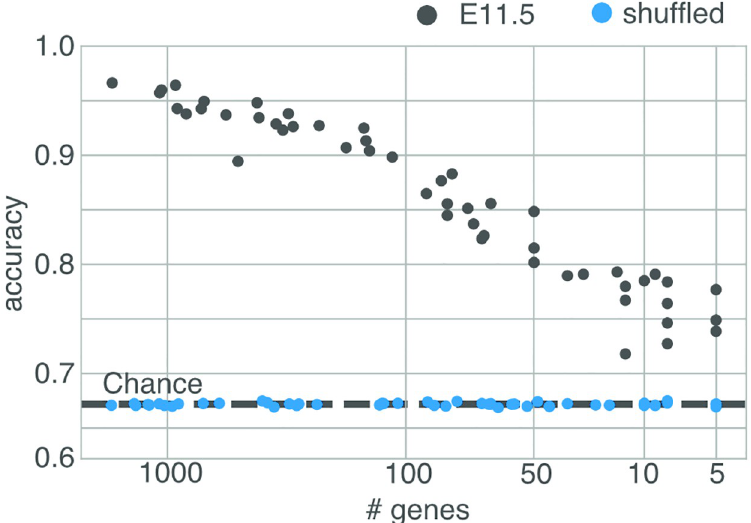
Fig 7. Random sets of genes of various sizes from embryonic age E11.5 were selected, and the spatial hierarchy they exhibit was compared to the hierarchy exhibited by the grand set of all genes at hierarchy. To compare hierarchies all voxels are projected onto both hierarchies. For each matching choice the score is incremented proportionally to the depth of the bin. As such, 1 indicates that the all voxels are sorted into corresponding nodes of the hierarchies, and the dotted line indicates the score if all voxels were sorted into hierarchical bins randomly (as in the shuffled case). The hierarchy established from a set of 20 random genes already agrees largely above chance with the original pattern. Black dots represent the accuracy from the data at E11.5. Blue dots indicate the same experiment, but on shuffled expression data.